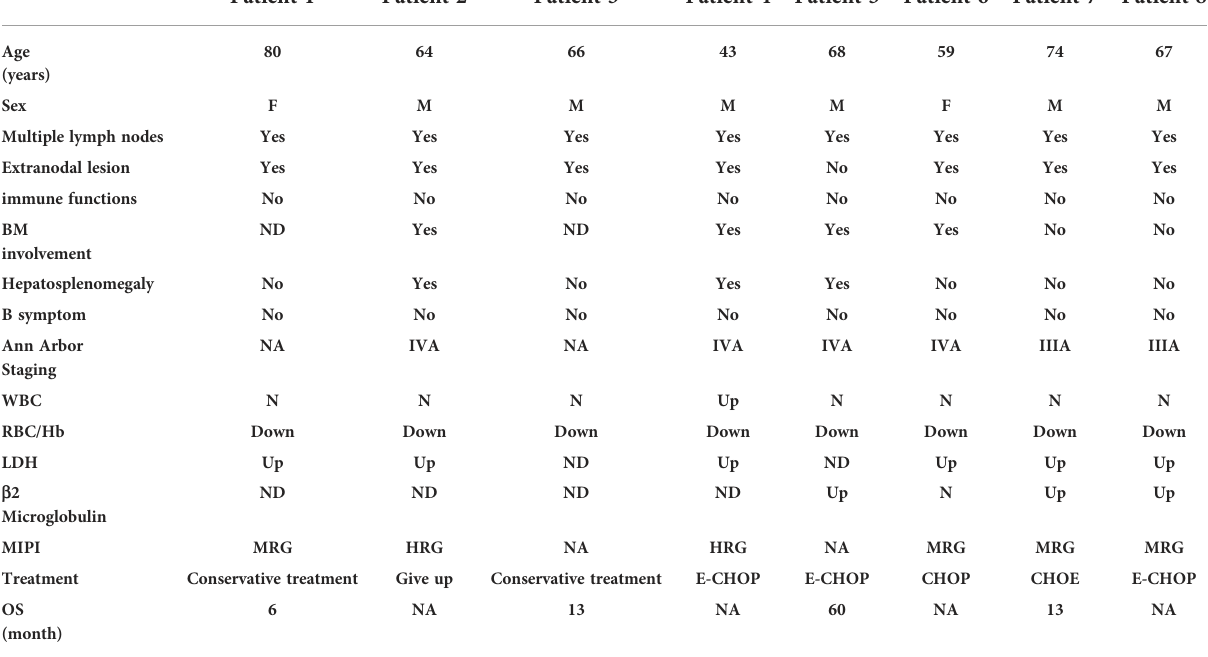
TABLE 2 Clinicopathologic features of MCL with EBER